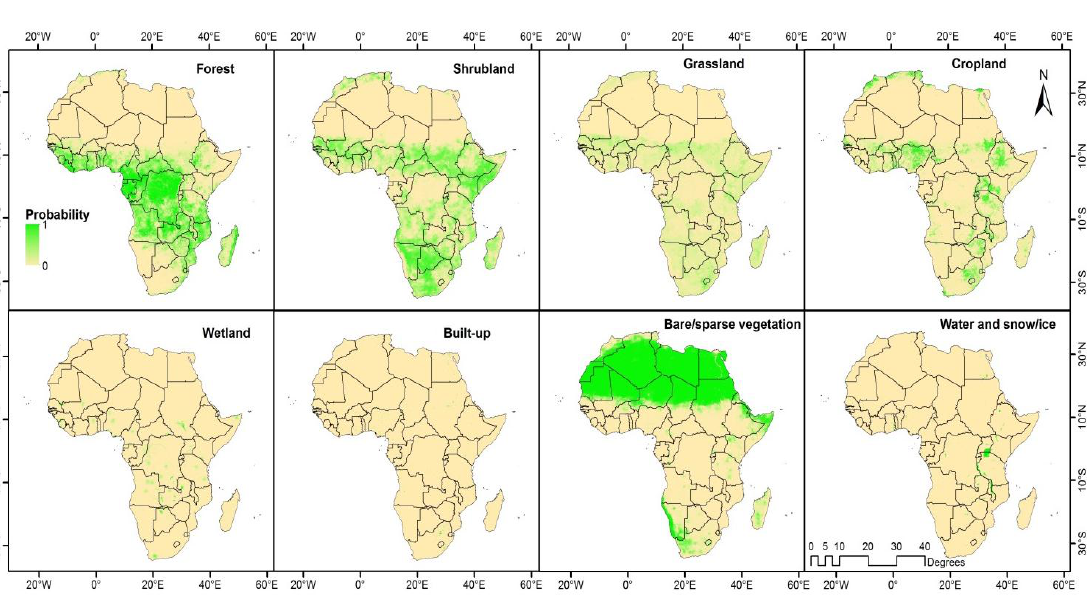
Figure 10. Probability maps of LC classes.